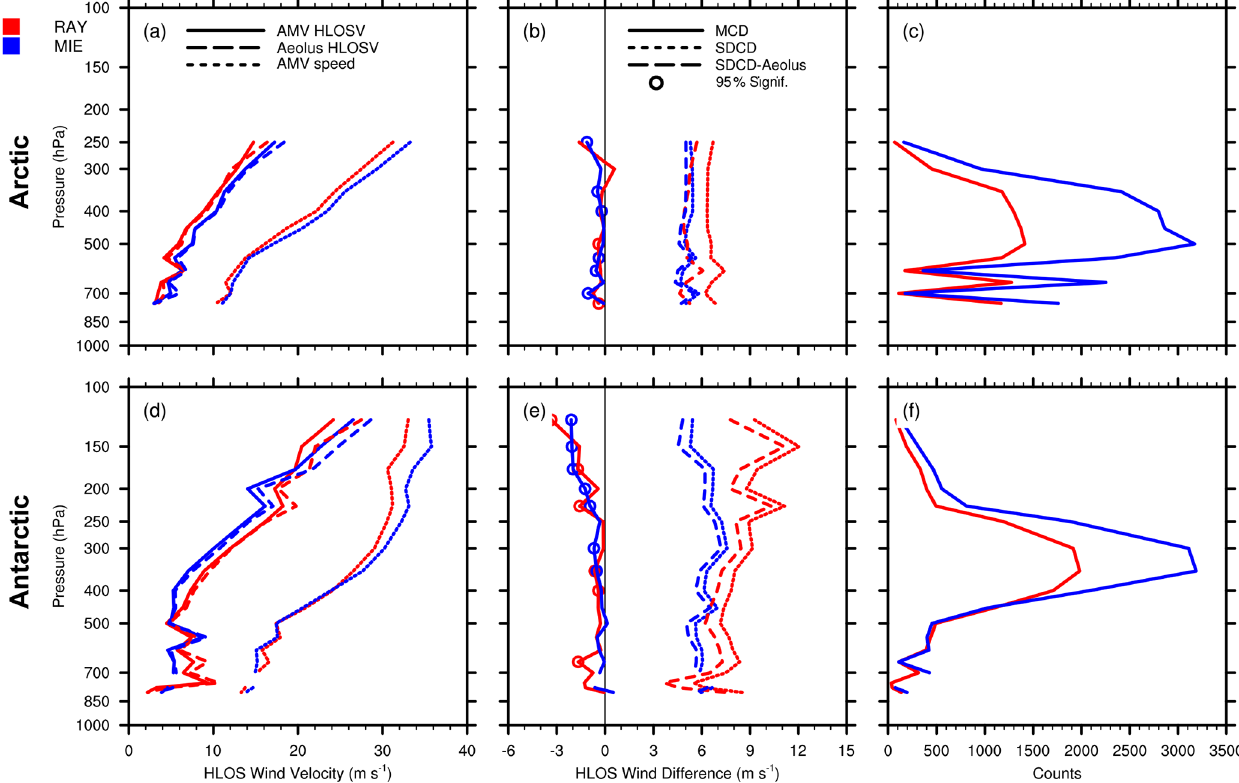
Figure 13. Vertical profiles of co-located LEO AMVs and RAY (red) and MIE (blue) winds. The top row shows the Arctic (north of 60 ◦ N), (a) mean AMV HLOSV (solid lines), Aeolus HLOSV (long dashed lines; ms − 1 ), and mean AMV wind speed (short dashed lines; ms − 1 ), (b) MCDs (solid), SDCDs (short dashed), and AMV HLOSV error, as represented by SDCD–Aeolus L2B uncertainty (long dashed; ms − 1 ), and (c) co-location counts. Panels (d–f) are as in panels (a–c) but for the Antarctic (south of 60 ◦ S). Colored open circles indicate levels where MCDs are statistically significant at the 95% level ( p value < 0.05), using the paired Student’s t test. Vertical zero lines are displayed in the center panels in black. Levels with observation counts > 25 are